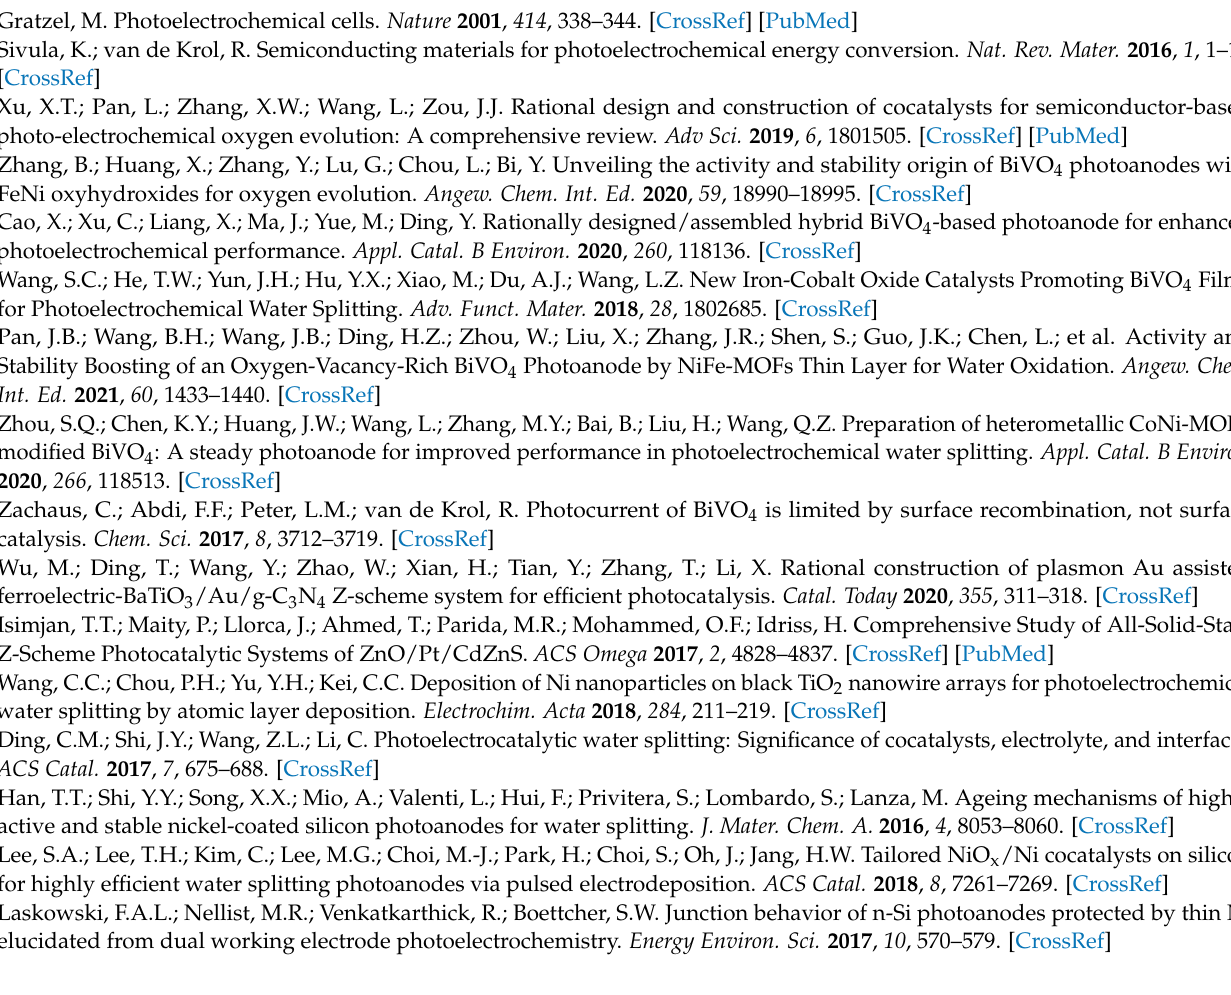
TEM images of the different photoanodes; Figure S4: LSV curves of Ni@NiO/BiVO 4 films obtained by different conditions; Figure S5: Cyclic voltammograms of the photoanodes measured at scan rates ranging from 20 mV/s to 120 mV/s; Figure S6: OCP values of the different photoanodes; Figure